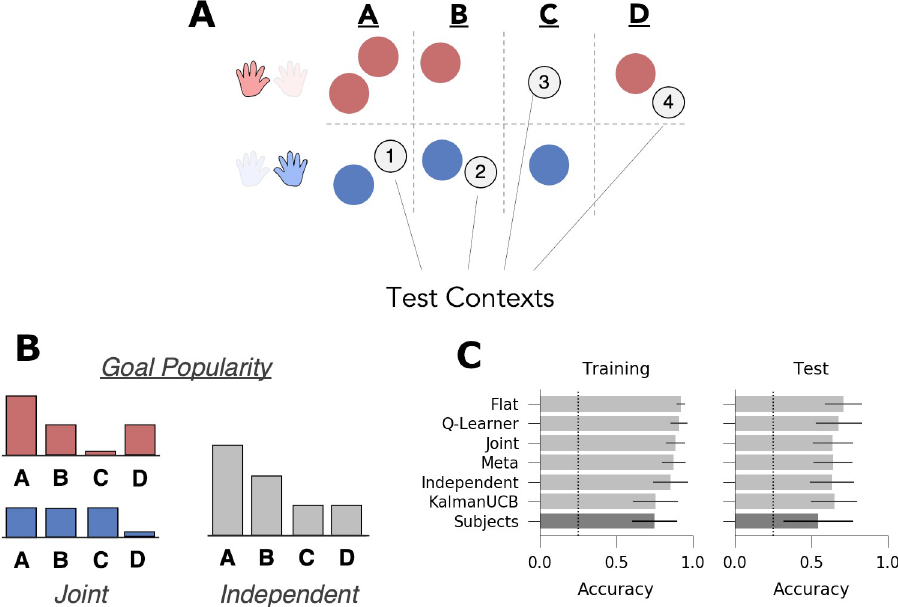
Fig 5. Experiment 2: Independent structure. A : Subjects saw seven contexts (circles) during training, each paired with one of two mappings ( red : high popularity, blue : low popularity) and one of four goals (A, B, C or D). Two of the high popularity goals were paired with multiple mappings, suggestive of independent structure. Subjects learned to navigate in an additional four novel test contexts following training (grey circles). B : Goal popularity in the training environment as a function of mapping (as tracked by a joint agent, left) and collapsed across all contexts (as tracked by an independent agent, right). C : Goal accuracy of models (light grey) and human subjects (dark grey) across all trials in the training and test contexts. Chance performance denoted with dotted line. Error bars denote standard